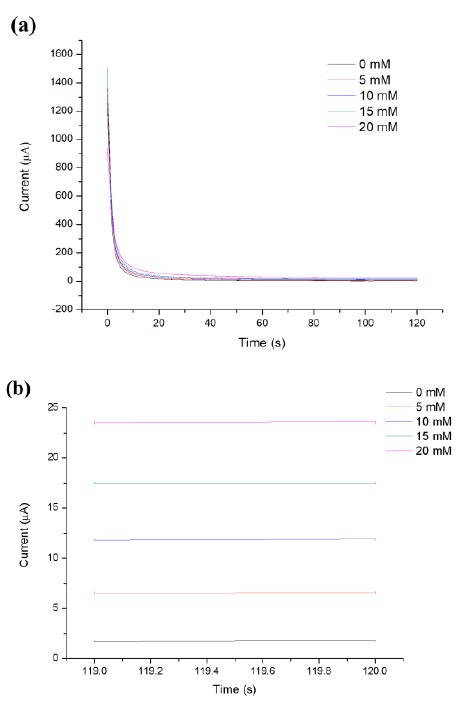
Figure 5. ( a ) Representative CA current curves measured at different concentrations. ( b ) The zoomed-in views of the CA current curves in ( a ) from 119 to 120s.